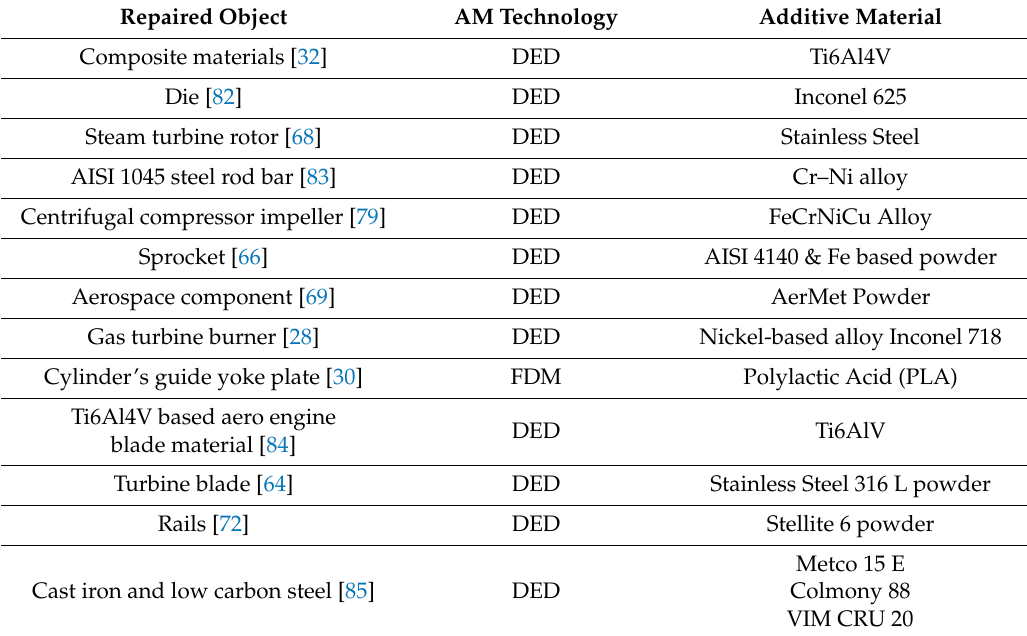
Table 6. AM reparation of objects using di ff erent types of additive